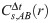
Dynamics of different sub-compartment types of loci.(A) Shown are the loci-averaged MSDs of A and B type loci. The log-log plot in the inset indicates that the diffusion exponent β is effectively identical for the A and B type loci. The locus-dependent dynamics is provided in S3 Fig. (B) Correlation length as a function of Δt calculated from spatial correlation functions Cs,ABΔt(r), Cs,BBΔt(r), Cs,AAΔt(r) between different types of loci AB, BB, and AA, respectively.